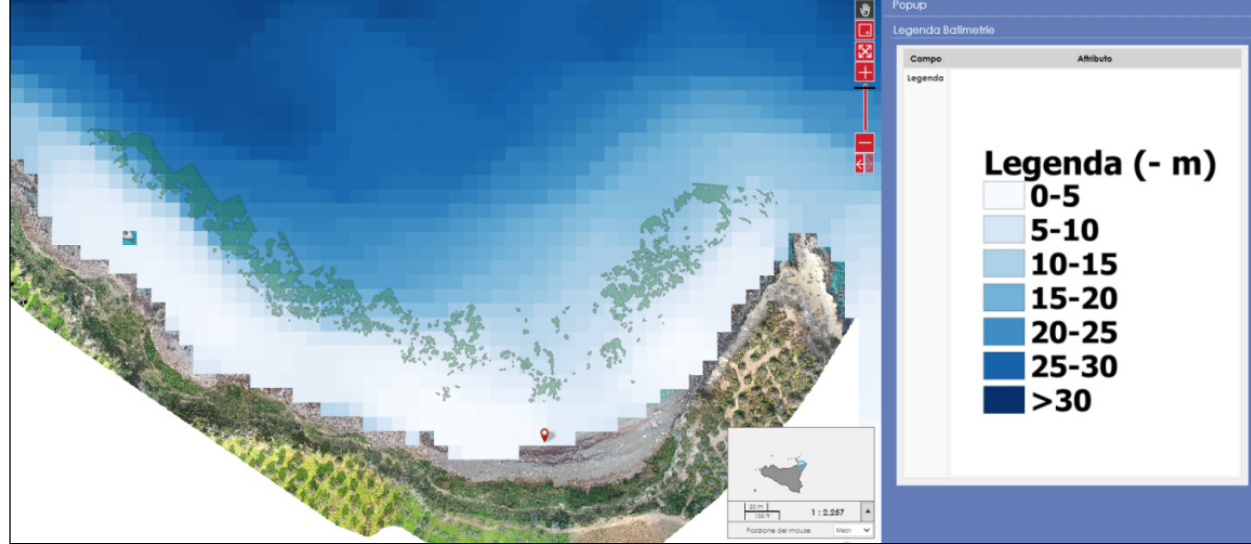
Figure 12. Distribution of Posidonia oceanica according to the various bathymetric zones on the PB of Capo Milazzo (Messina).